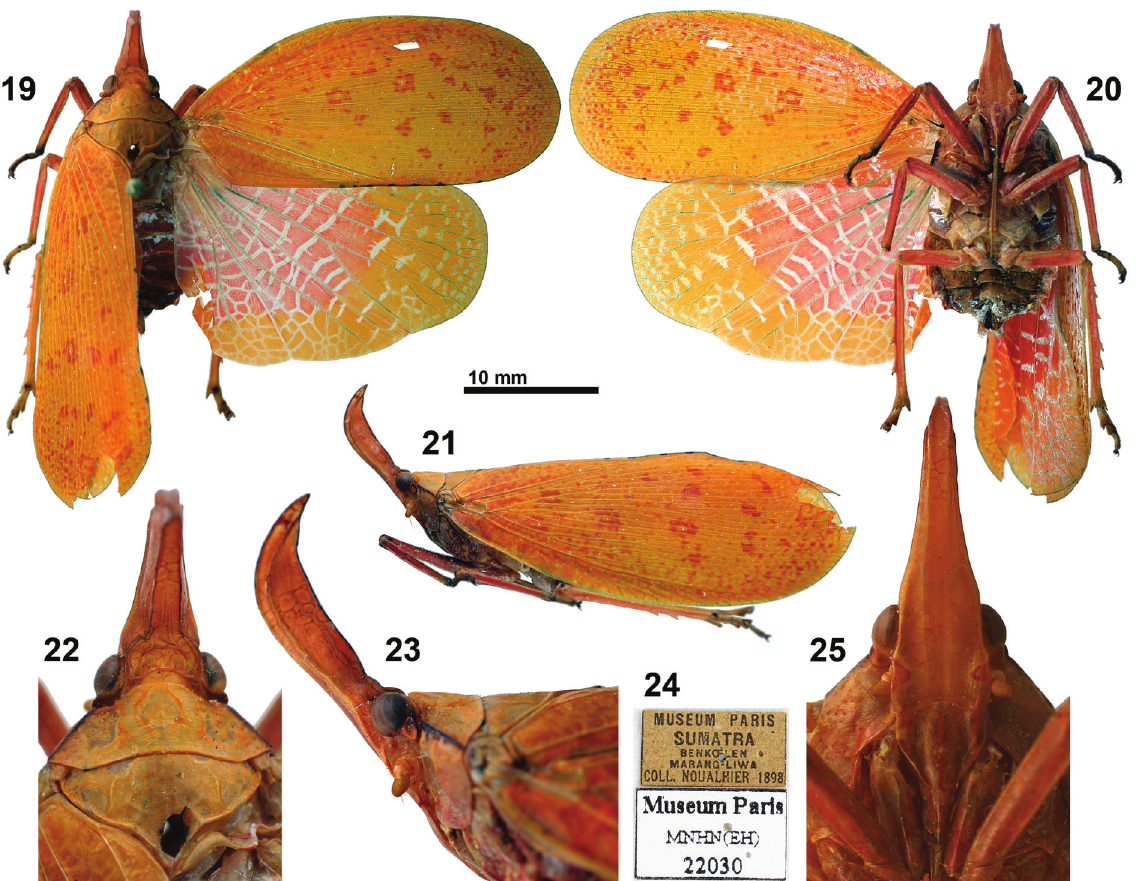
Figs 19–25. Egregia laprincesse sp. nov., holotype, ♀ (TL: 31.6 mm). 19 . Habitus: dorsal view. 20 . Habitus, ventral view. 21 . Habitus: left lateral view. 22 . Head and thorax: dorsal view. 23 . Head and thorax: left lateral view. 24 . Labels. 25 . Head: normal view of frons (Figs 22-25 not to